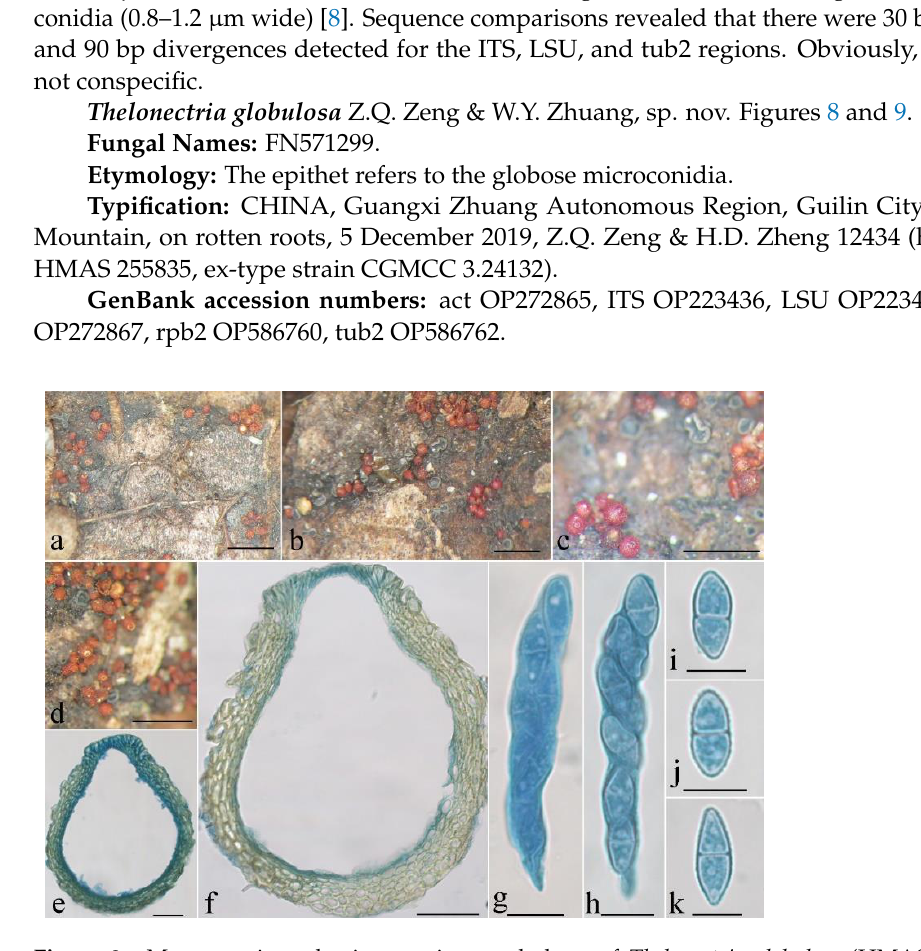
Figure 9. Colonial and microscopic morphology of Thelonectria globulosa (CGMCC 3.24132). ( a ) Col- ony after 2 week at 25 °C on PDA; ( b ) colony after 2 week at 25 °C on SNA; ( c ) conidiophores in